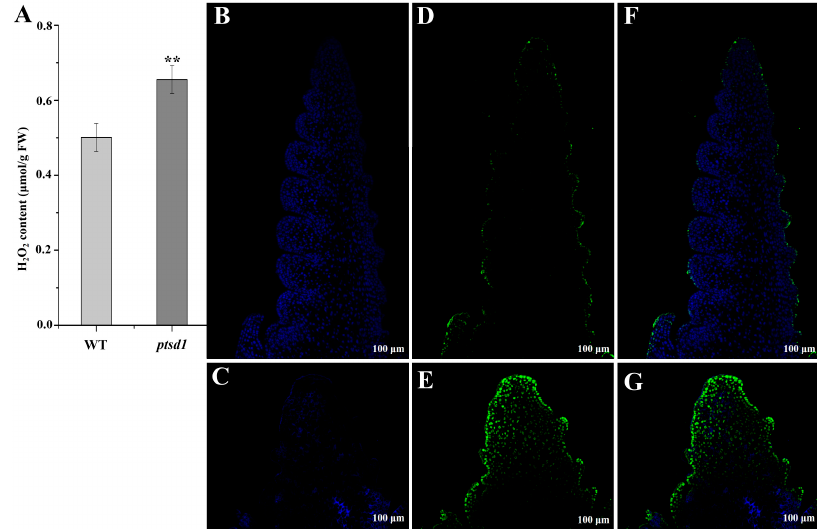
Figure 5. The H 2 O 2 contents ( A ) and TUNEL assay ( B – G ) of WT and ptsd1 . ( A ) The H 2 O 2 contents in young spikes of WT and ptsd1 . The asterisks represent the significant difference between WT and ptsd1 (**: p ≤ 0.01). FW, fresh weight. ( B – G ) TUNEL assay results of WT and ptsd1. The young spikes were at late double ridge stage. The spikes of WT ( B ) and ptsd1 ( C ) stained with DAPI. Positive stained results of WT ( D ) and ptsd1 ( E ) with fluorescein. ( F ) is the overlap picture of ( B ) and ( D ); ( G ) is the overlap picture of ( C ) and ( E ). Green indicates the programmed cell death (PCD).